Question: Based on the figure, does the quantity rise or fall?
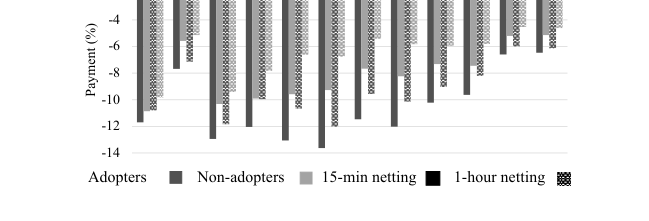
Answer: increasing